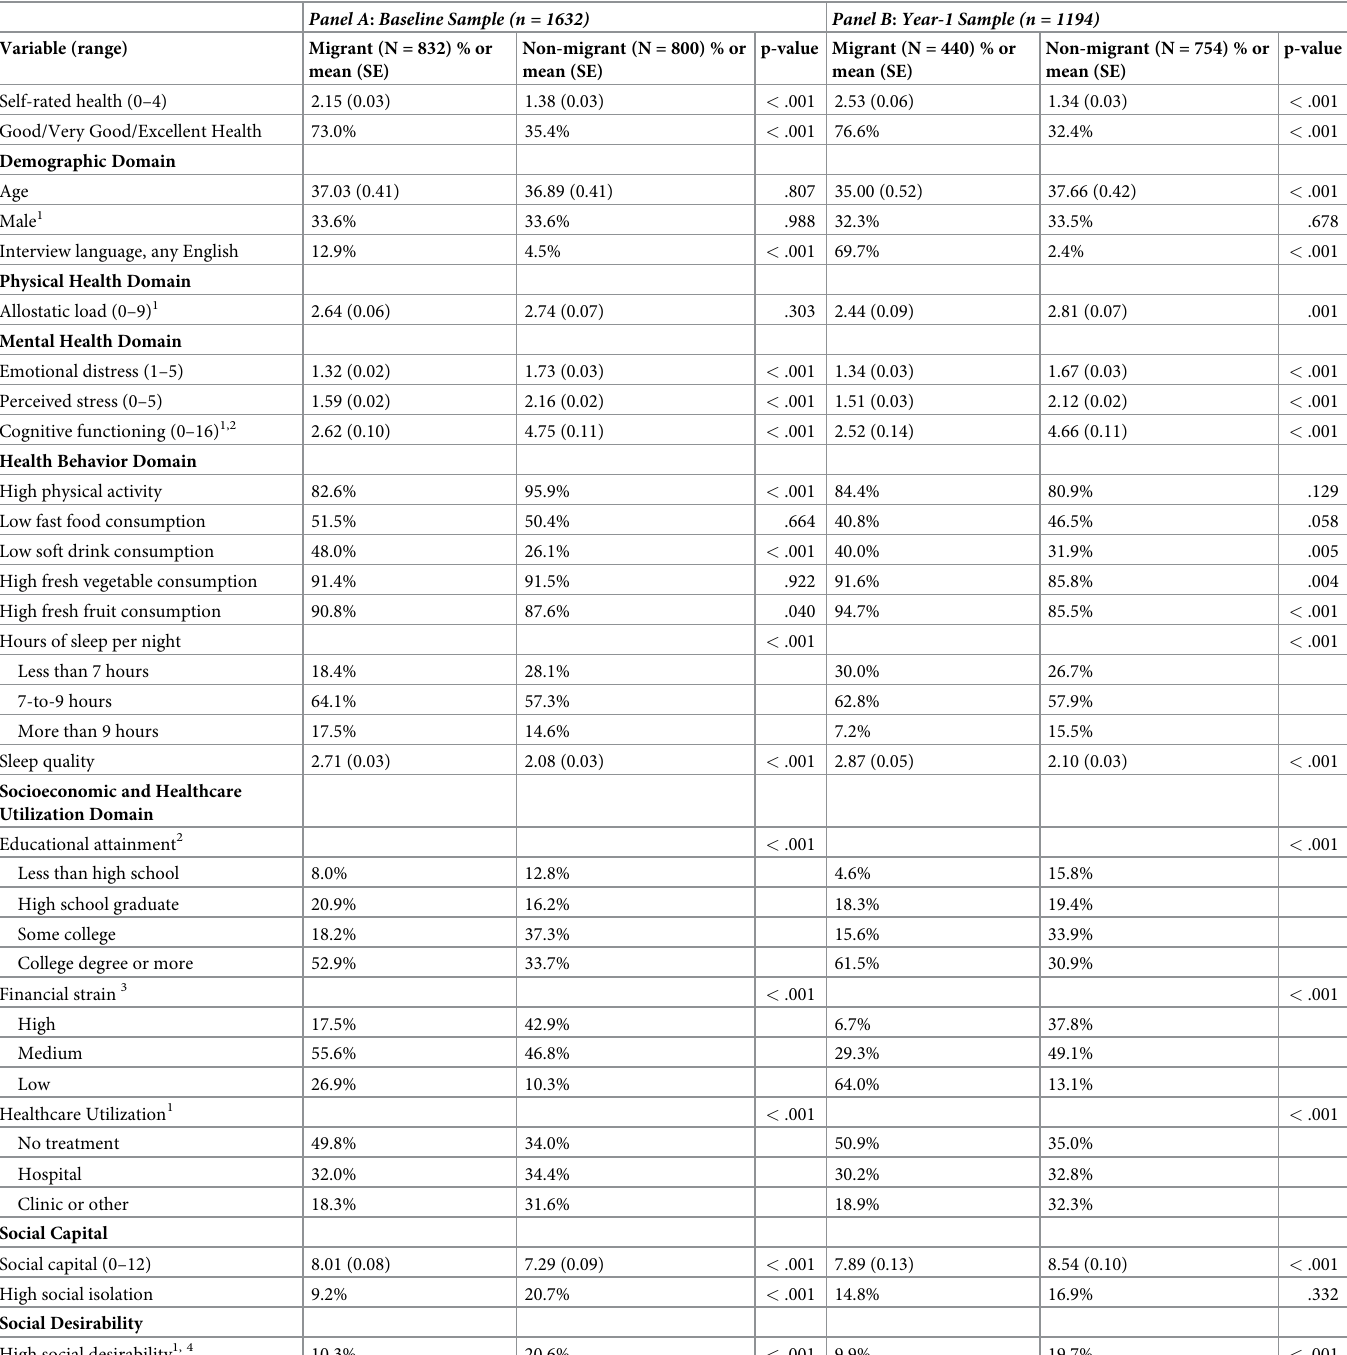
Table 1. Summary statistics for HoPES sample at baseline and 1-year